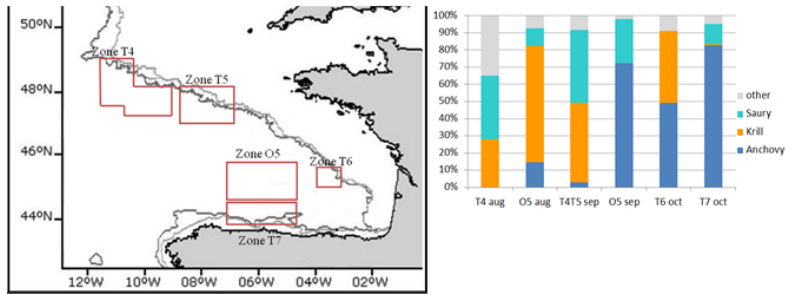
Figure 6. Diet composition of albacore sampled in distinct areas and periods in the Bay of Biscay during the summer and autumn of